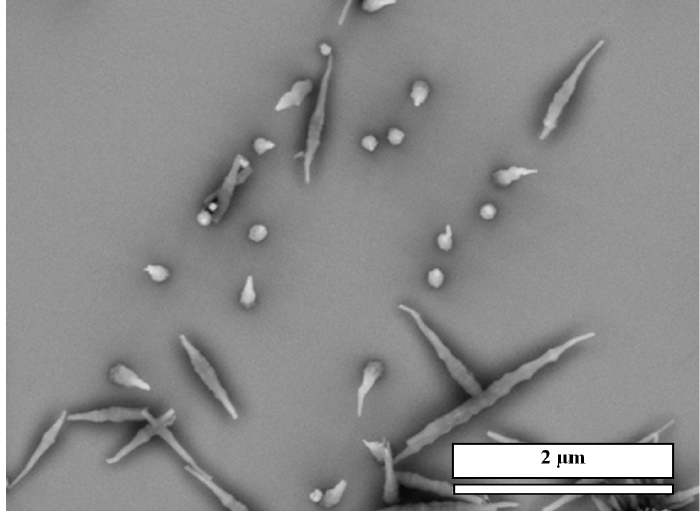
Figure 8. SEM images of CA/M complexes fabricated on gold substrates from 0.001 M melamine and 0.01 M CA at a 1:10